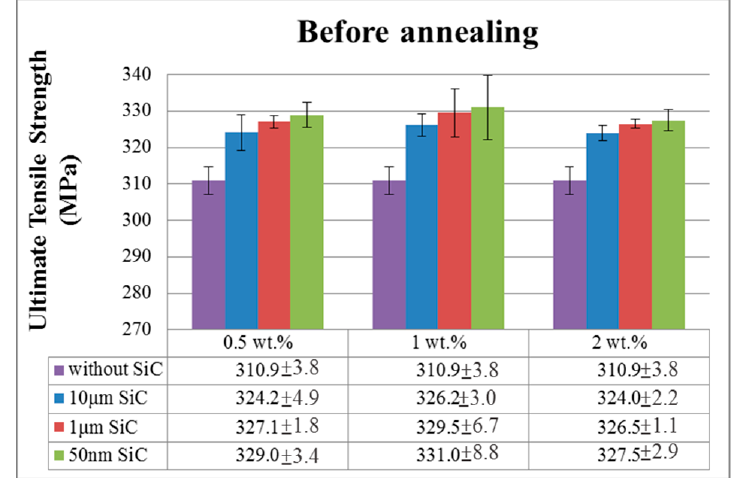
Figure 2. Ultimate strength of the AZ61/SiCp MMC extruded plates before annealing.